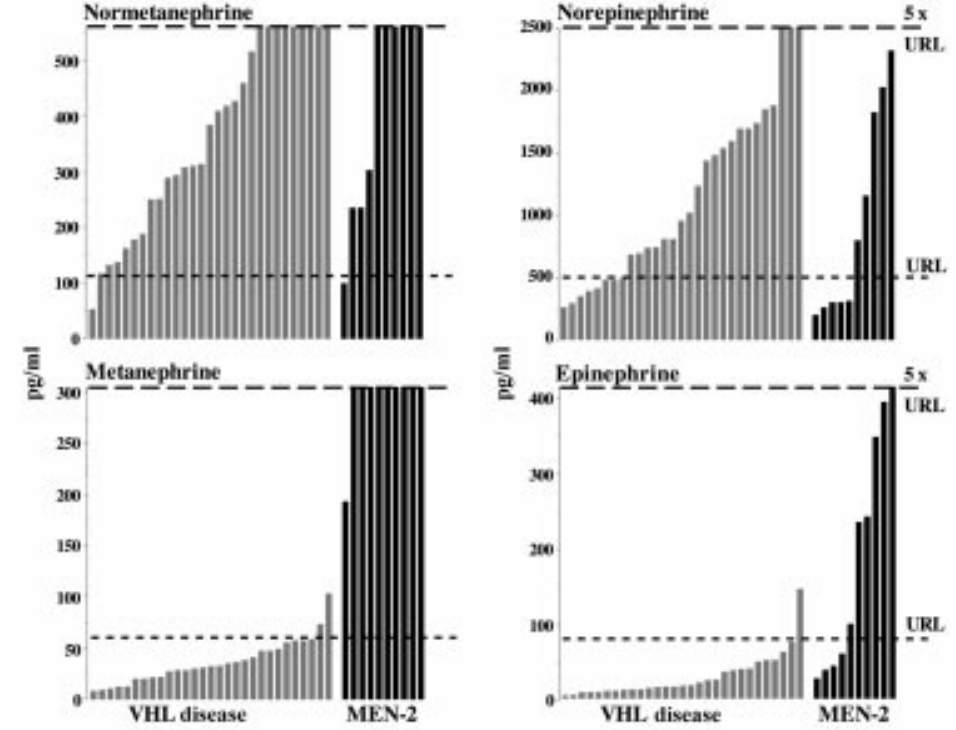
Figure 3 - Plasma concentrations of normetanephrine, metaneph- rine, norepinephrine and epi- nephrine in 29 patients with von Hippel-Lindau (VHL) disease and pheochromocytoma (grey bars) and 10 patients with multiple endocrine neoplasia type 2 (MEN-2) and pheochromocy- toma (black bars). Each bar rep- resents a concentration of one of the 4 analytes for a single pa- tient. The lower dashed lines show the upper reference limits (URL) of normal levels. Concen- trations above these lines are high and those below are nor- mal. The upper dashed lines show levels at 5 times the upper reference limits. Concentrations above the horizontal lines almost certainly indicate the presence of a